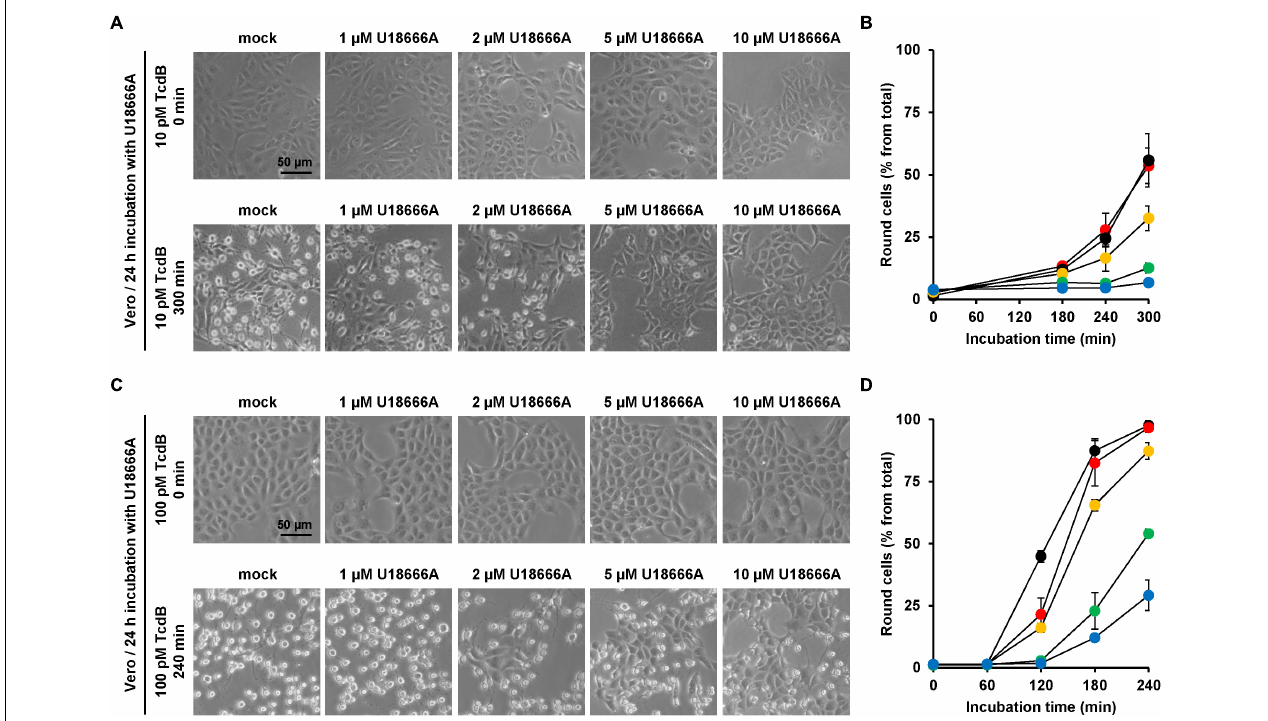
FIGURE 3 | Effect of U18666A on the TcdB-induced cell rounding of Vero cells. (A,C) Vero cells pretreated for 24 h with increasing concentrations of U18666A as indicated or without pretreatment (mock) were intoxicated with (A) 10 pM or (C) 100 pM TcdB. Representative images were taken microscopically after time point 0 min [upper row in (A,C) ] and 300 min [lower row in (A) ] or 240 min [lower row in (C) ]. (B,D) Quantification of the TcdB-induced cell rounding over time in mock-treated (black filled circles) and 24 h U18666A-pretreated HeLa cells (1 µ M, red filled circles; 2 µ M, orange filled circles; 5 µ M, green filled circles, 10 µ M, blue filled circles). Graphs in (B,D) show mean percentage values of round cells as indicated by three parallel experiments performed in independent wells. Error bars represent ±